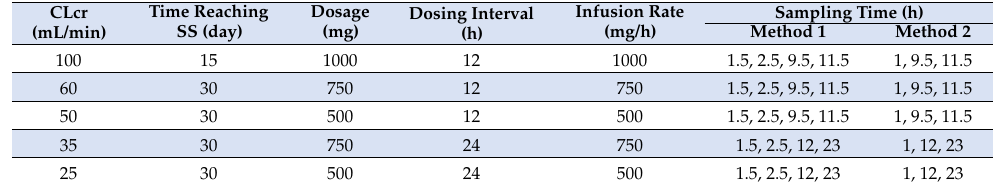
Sampling Time (h) CLcr